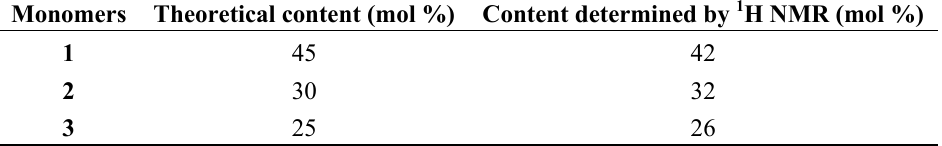
Table 1. Content of the amino acid containing building blocks in the final polymer.